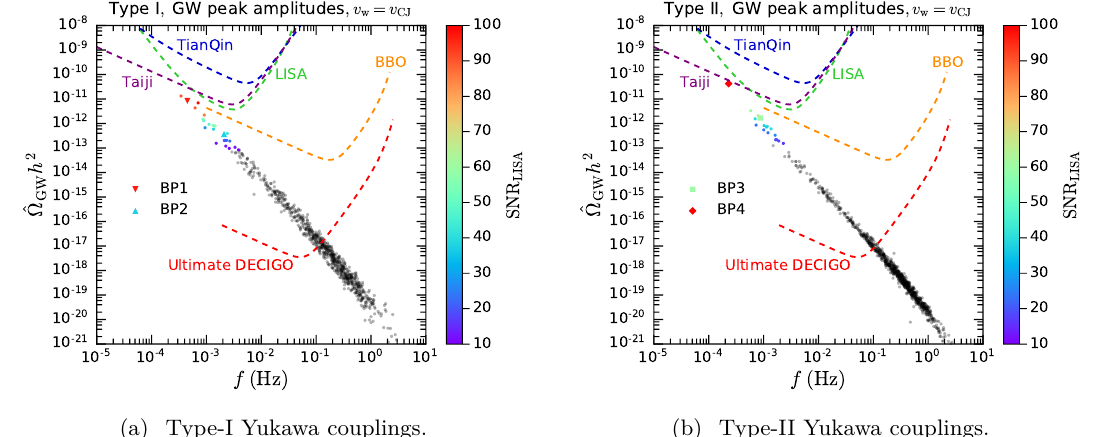
Figure 4 . Peak amplitudes of the total GW spectra versus frequency for the parameter points with type-I (a) and type-II (b) Yukawa couplings assuming Jouguet detonations. Sensitivity curves for the future space-based GW interferometers LISA [51], Tianqin [54], Taiji [56], BBO [60], and ultimate DECIGO [58] are also plotted. The color axes denote the LISA signal-to-noise ratio SNR LISA for the parameter points with SNR LISA > 10 . The gray points yield SNR LISA < 10